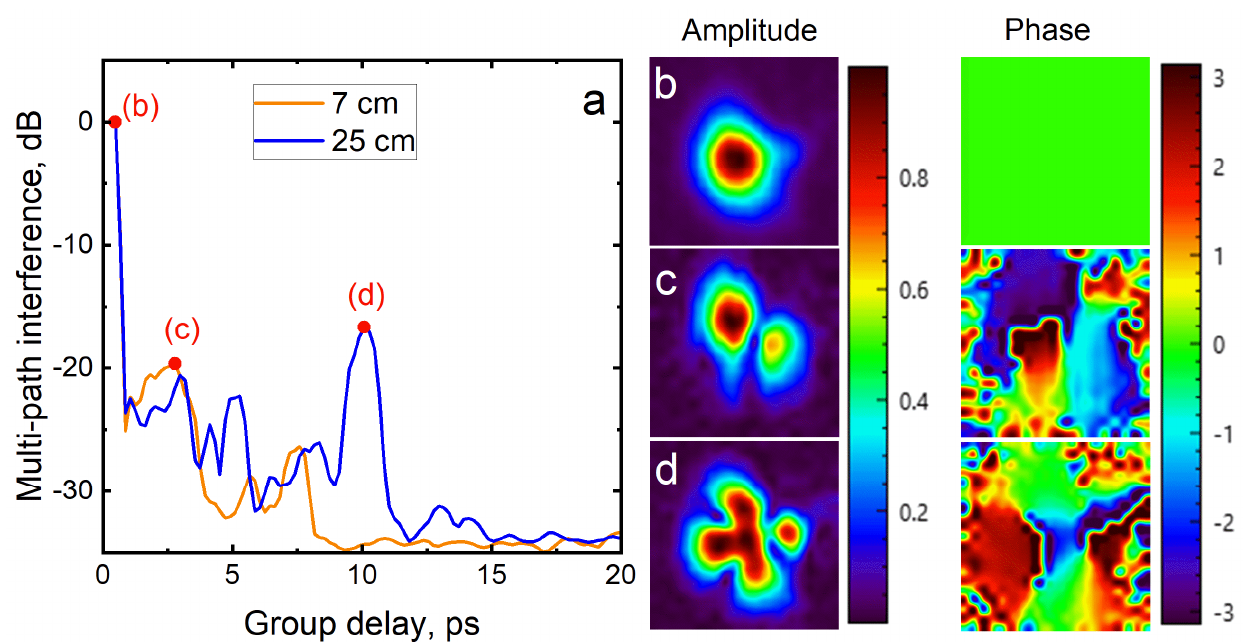
Figure 10. ( a ) The results of S 2 measurement; ( b – d ) retrieved mode intensities and corresponding phase.